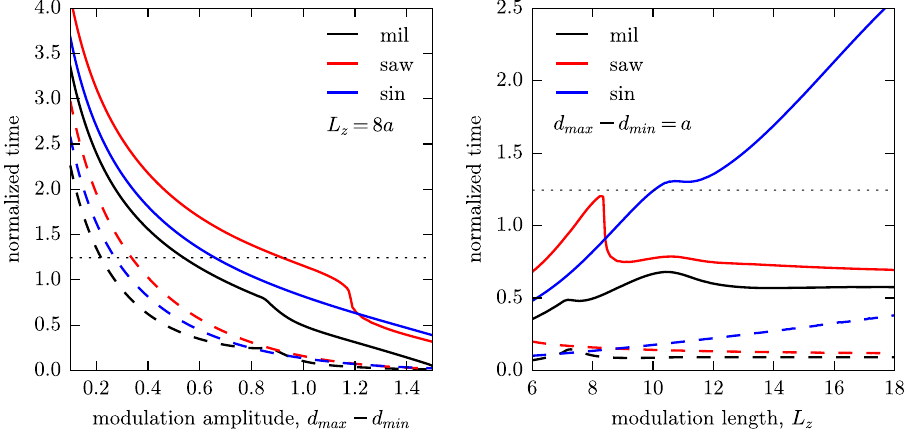
Figure 6. Dependence of the pinch-off (dashes) and coalescence (lines) times on the modulation amplitude, d max − d min , (left) and on the modulation length L z (right). In all calculations, the average diameter is d av = ½( d max + d min ) = 1.2 a . The dotted line represents the ovulation time for a straight pore with diameter d av